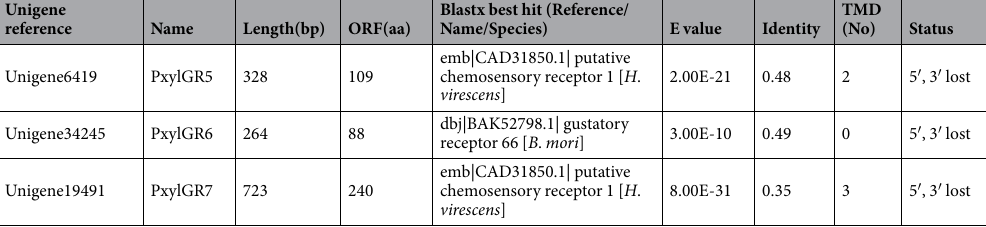
Table 2. Candidate olfactory receptor and gustatory receptor